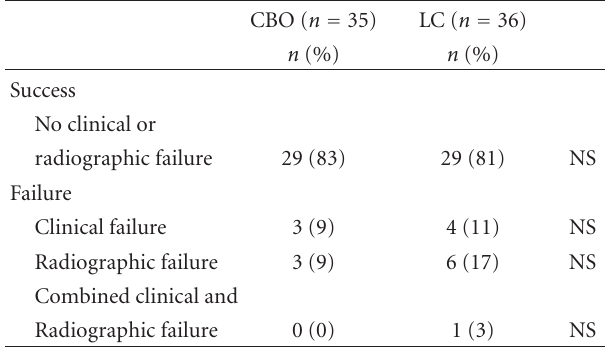
Table 2: Clinical and radiographic status of treated teeth at